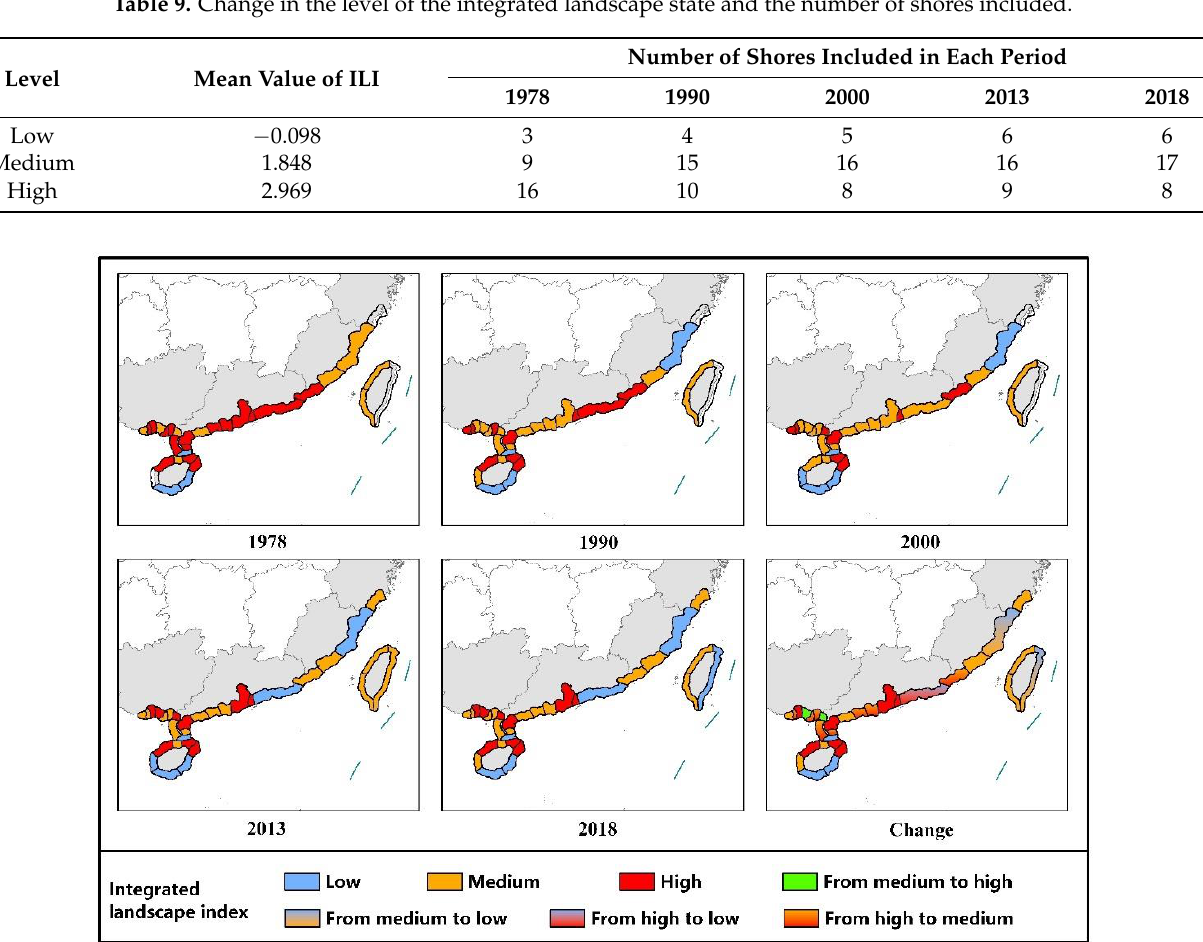
Table 9. Change in the level of the integrated landscape state and the number of shores included.